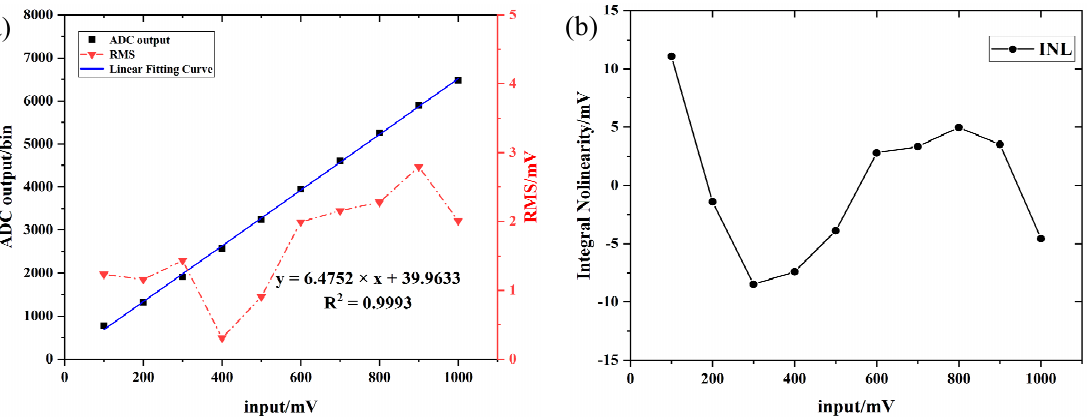
Figure 14. ( a ) Linearity fit and RMS noise of the entire readout chain. ( b ) Integral Nonlinearity corresponds to different input values.